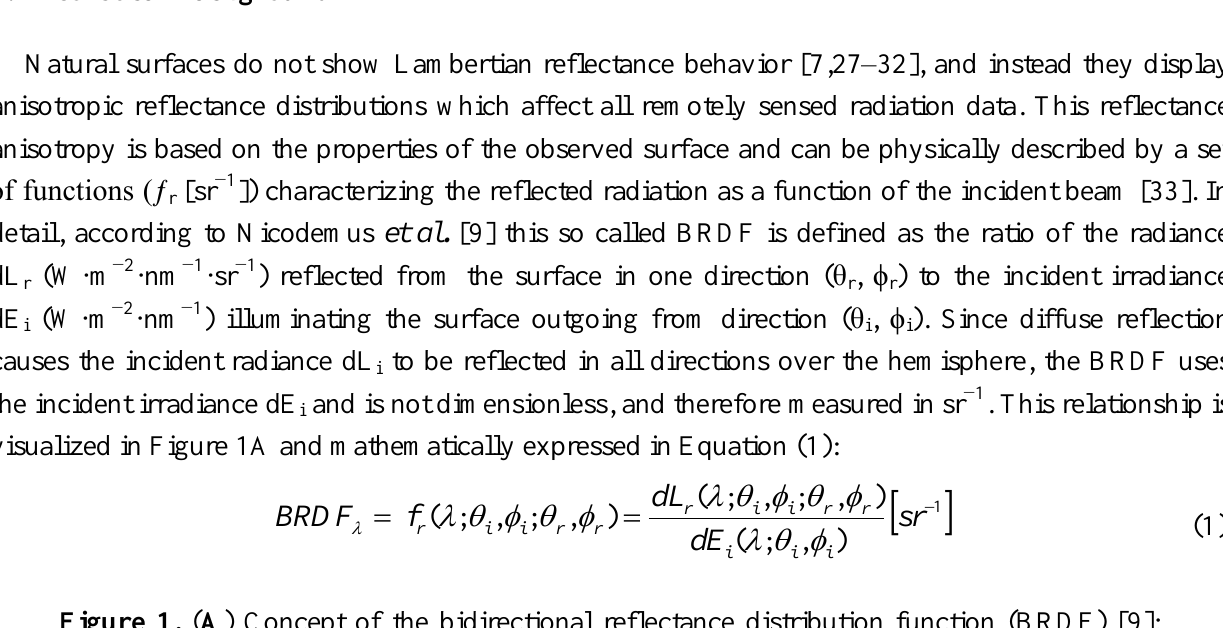
Figure 1. ( A ) Concept of the bidirectional reflectance distribution function (BRDF) [9]; ( B ) Reflectance nomenclature as a function of geometrical aspects used in this study